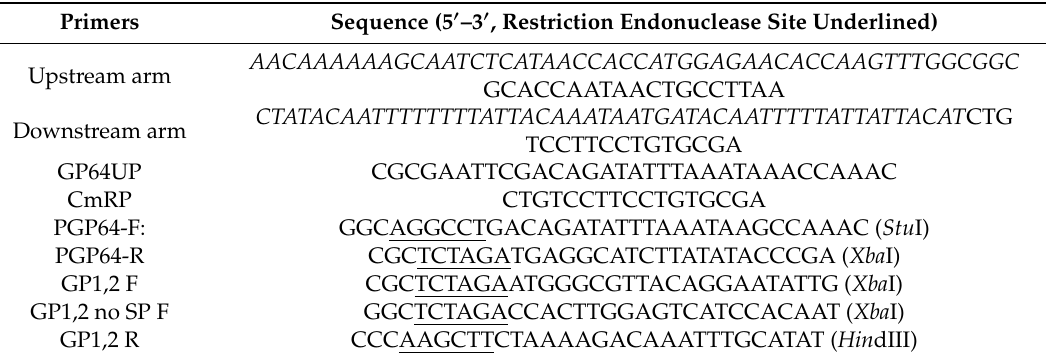
Table 1. Primers used in this